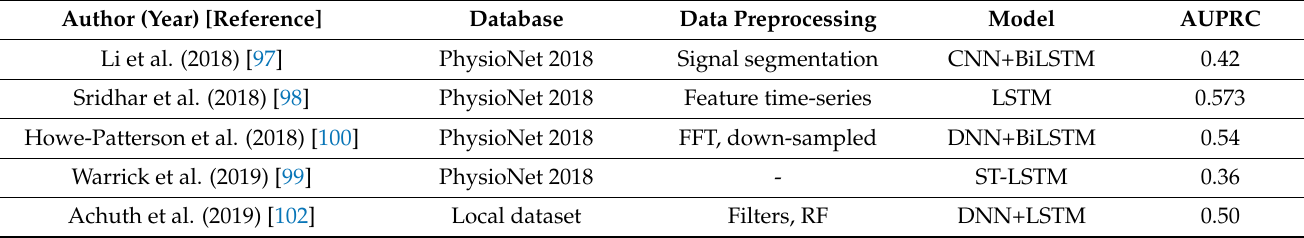
Table 7. Analysis of application of CNN+LSTM in sleep arousal.